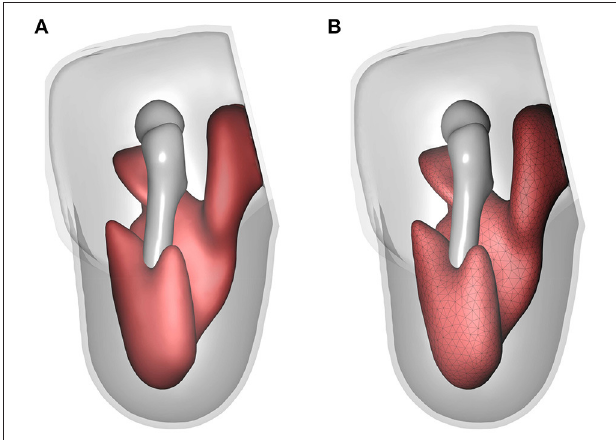
FIGURE 10 | Fused-muscle model. The geometry and FE mesh of the fused muscle are shown in (A,B) , respectively.